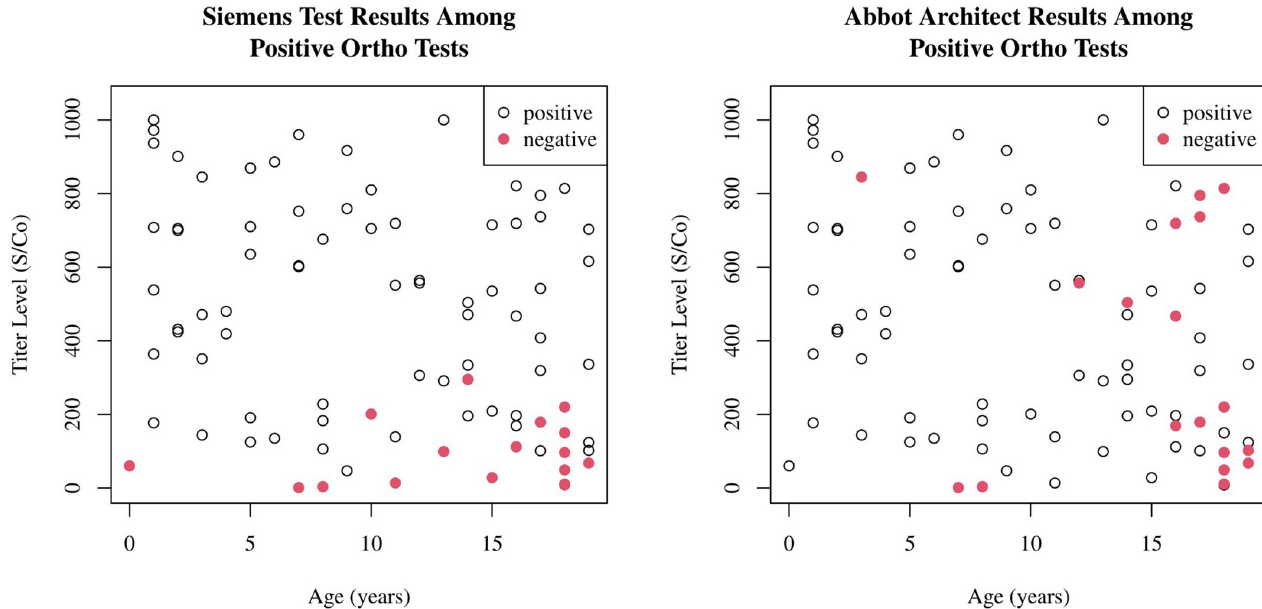
Fig 2. Scatterplots showing age versus titer levels of the reactive tests on the Ortho Clinical Diagnostic Vitros assay, with orthogonal testing on the Siemens assay (2a) and Abbot assay (2b). Negative tests on orthogonal testing are colored red.